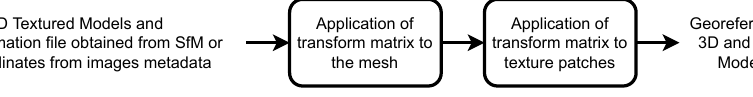
Figure 22. Georeferencing